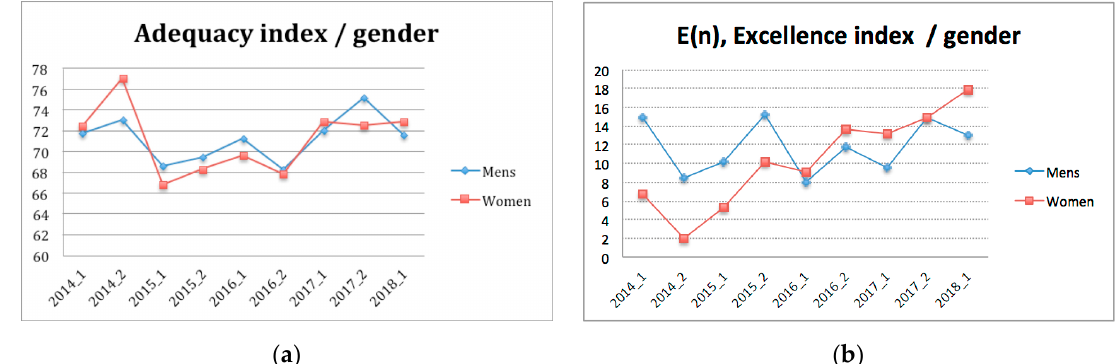
Figure 5. Adequacy ( a ) and excellence ( b ) indices, distinguished by gender.